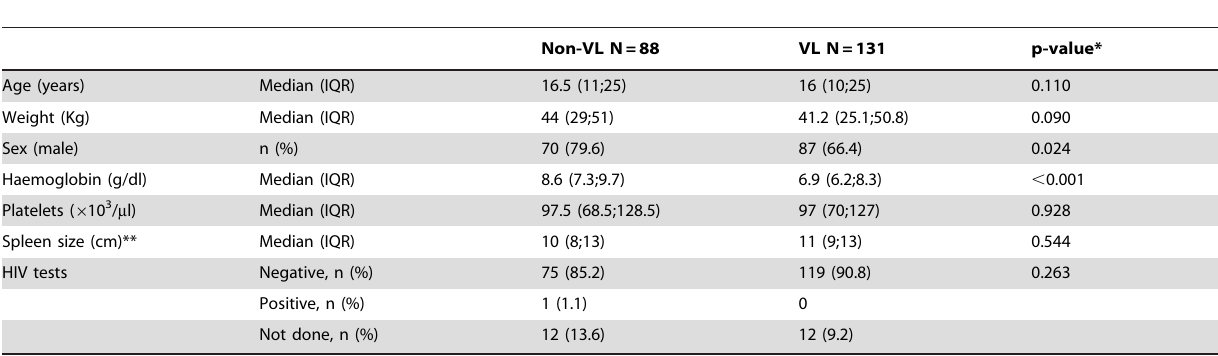
Table 1. Comparison of demographic and laboratory characteristics between VL and non-VL patients in Kacheliba and Kimalel, Rift Valley province,